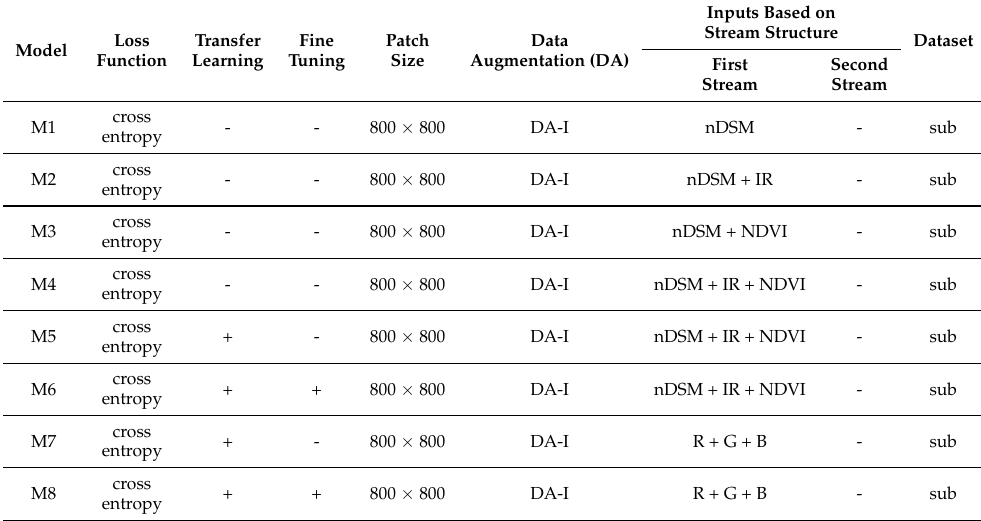
Table 3. Features of different training approaches and inputs using sub-datasets for single-stream segmentation